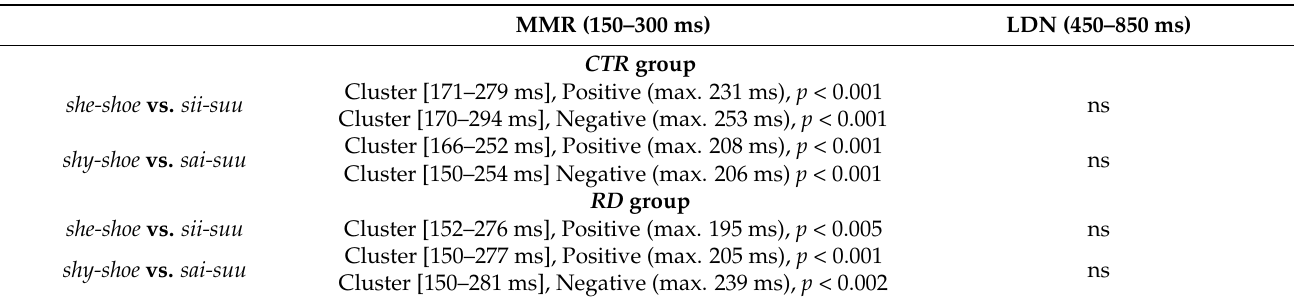
Table 2. Cluster-based permutation test results of comparison between English and Finnish difference waves for the CTR group and for the RD